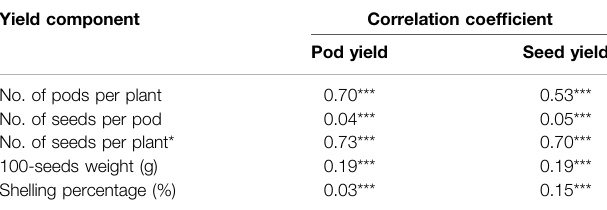
TABLE 2 | Correlation coef fi cients of yield components with pod yield and seed yield of 14 peanut lines testing across 12 locations. Yield